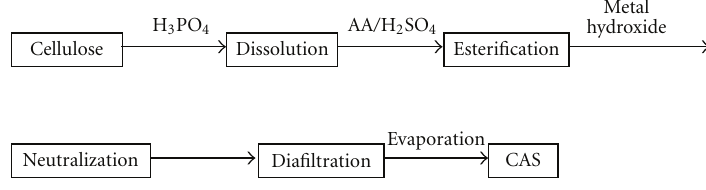
Figure 1: Scheme of homogeneous CAS